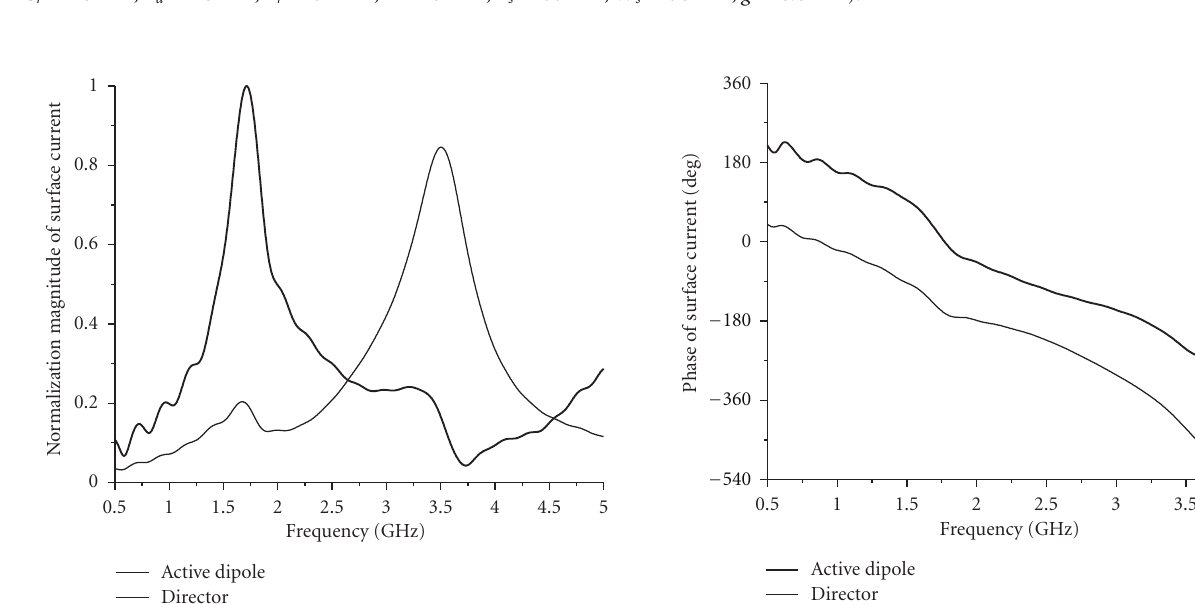
Figure 1: Structure of printed Yagi-Uda antenna unit. (a) Front view and (b) back view. ( W d = 4mm, W r = 4mm, W = 4mm, S d = 10 mm, S r = 18mm, L d = 28 mm, L r = 64mm, L = 29mm, L s = 66 mm, W s = 38mm, g = 0 . 8mm).